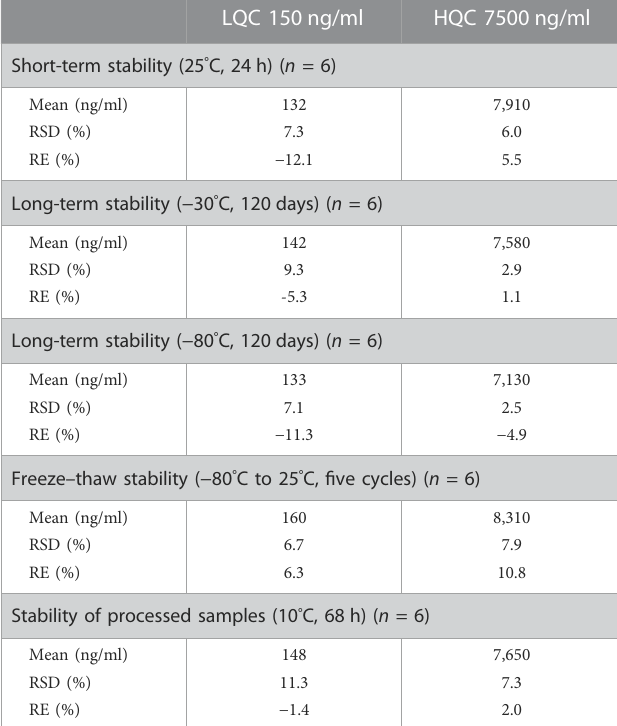
TABLE 2 Short-term stability, long-term stability, freeze – thaw stability, and TABLE 3 Short-term stability, long-term stability, freeze – thaw stability, and processed stability of etimicin in human serum samples. processed stability of etimicin in human urine LQC 150 ng/ml HQC 15000 ng/ml